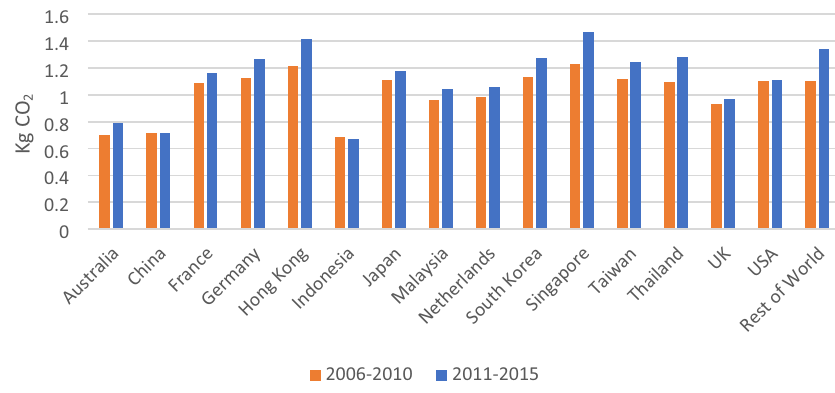
Fig. 5 Carbon intensity of Vietnam’s exports by